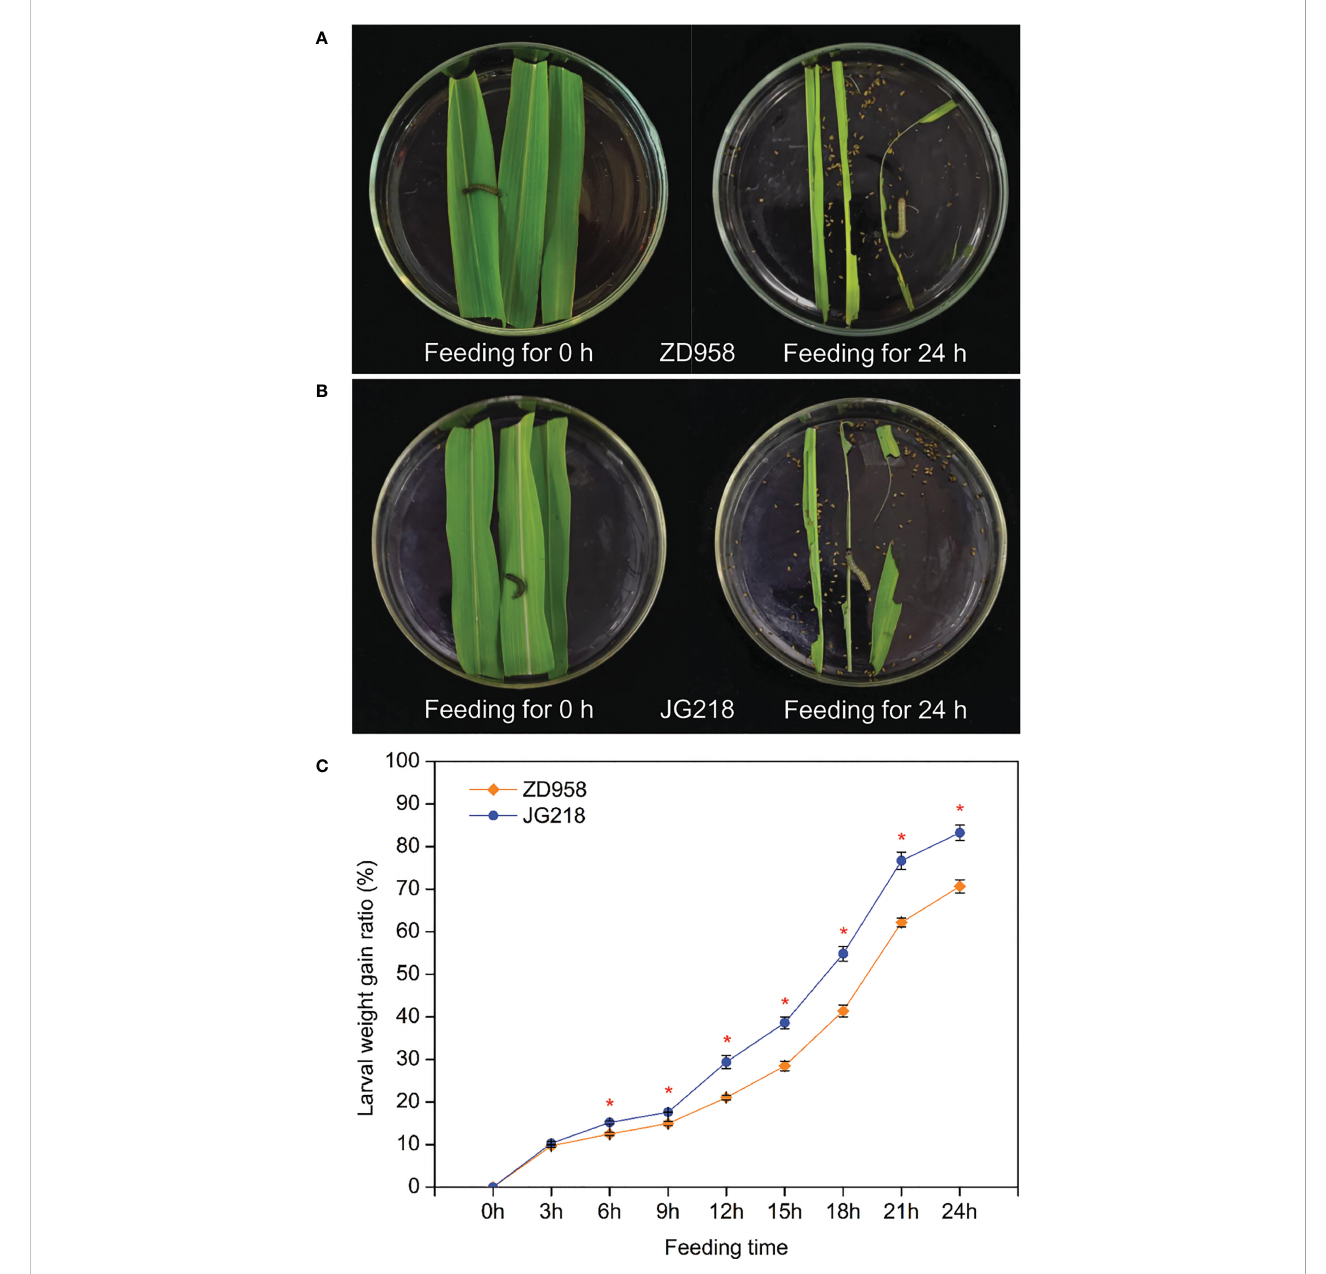
FIGURE 2 Larval weight gain for S. frugiperda fed on the detached leaves of ZD958 (A) and JG218 (B) . (C) Larval weight gain ratio. Data are shown as means ± SD ( n = 3, every n represents the mean of 10 values). The asterisk indicates signi fi cant differences ( P < 0.05) between ZD958 and